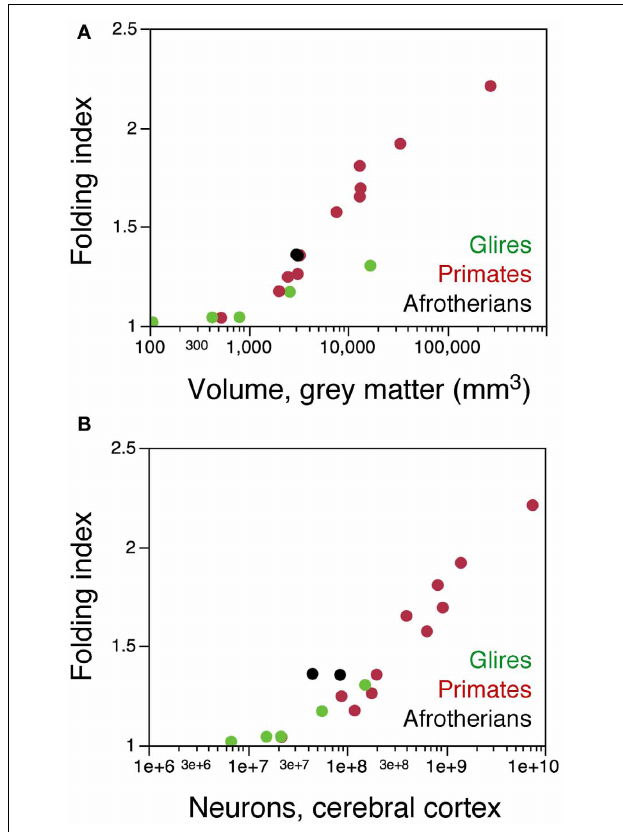
FIGURE 8 | The afrotherian cortex is folded differently from that of rodents and primates. (A) folding index of the cerebral cortex (ratio between the total surface area and the exposed surface area of the cortex) plotted as a function of the volume of the cortical gray matter for rodents (green), primates (red), and the two hyraxes (black). Notice that the two hyraxes appear to overlap with primates, but not rodents. (B) folding index of the cerebral cortex plotted as a function of the number of cortical neurons in each species. For similar numbers of cortical neurons, the cortex of the two hyraxes is more folded that the cortex of both primates and rodents. Data from Ventura-Antunes et al. (2013). Eulipotyphla and the smaller Afrotheria are lissencephalic, and data on their cortical surface areas and volumes were not